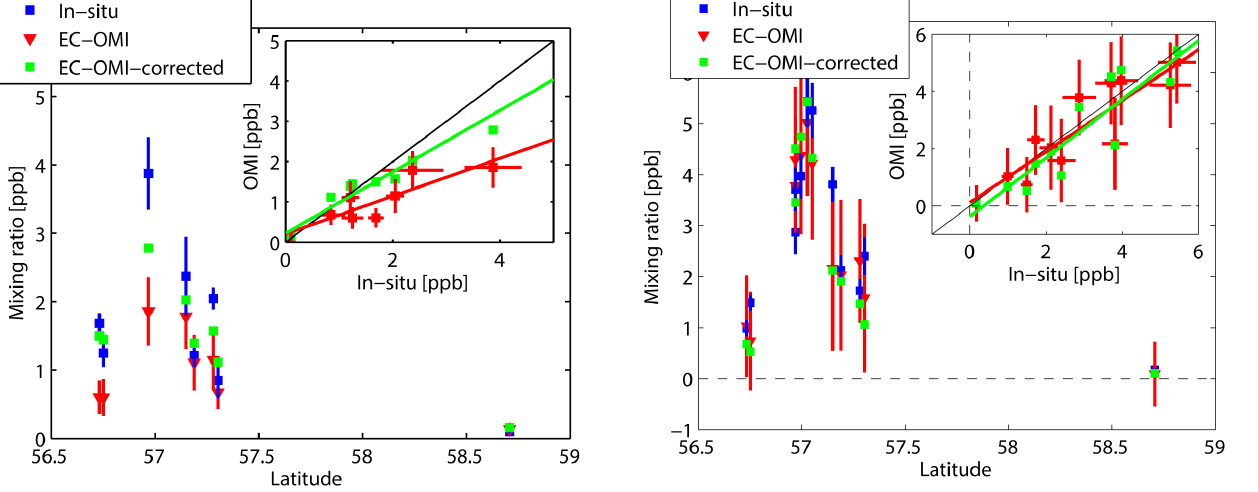
Fig. 11. Average (2005–2011) ground-based in situ and EC-OMI- derived NO 2 surface mixing ratio measurements as a function of WBEA station latitude. Inset is the scatter plot comparing ground- based measurements with the EC-vmr’s. The red represents original OMI-vmr’s, while the green is after accounting for smoothing and clear-sky bias. Errors bars denote twice the standard error of the mean. The ground-based measurements have been corrected for the interference effect and include this uncertainty in their error bars (see Table S1). The lines in the inset represent the linear fits.